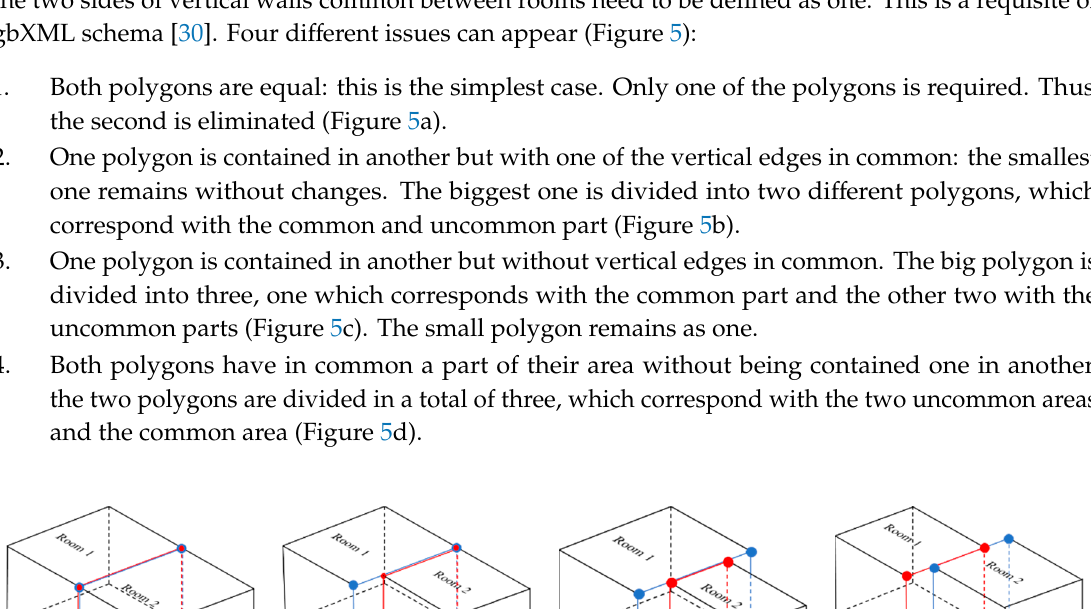
Figure 6. GbXML Structure. The main fields in the structure are highlighted in bold. The gbXML file is generated using the Qt classes for XML handling, specifically, QDomDocument, QDomElement and QDomText [31]. Each of the elements of the graph in Figure 6 represents a node. •